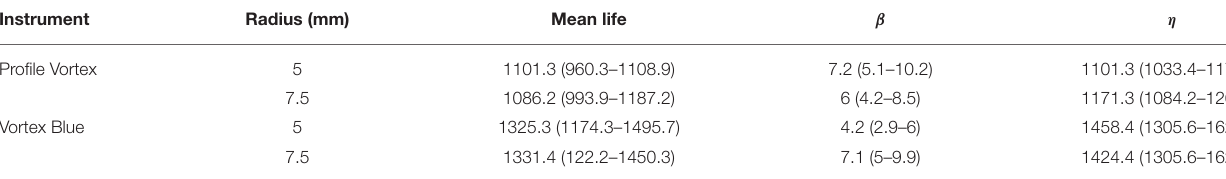
TABLE 2 | Output for Weibull calculations of the 4 groups ( n = 20 per group).